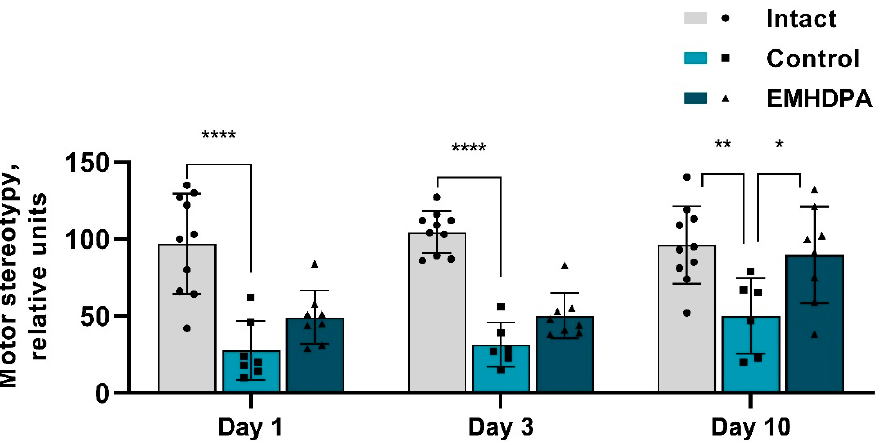
Figure 6. The effect of the studied drugs on the motor stereotypies in the actimetry test. Note: *— p < 0.05; **— p < 0.01; ****— p < 0.0001; 1—intact group; 2—control group; 3—group administered with EMHDPA 25 mg/kg.